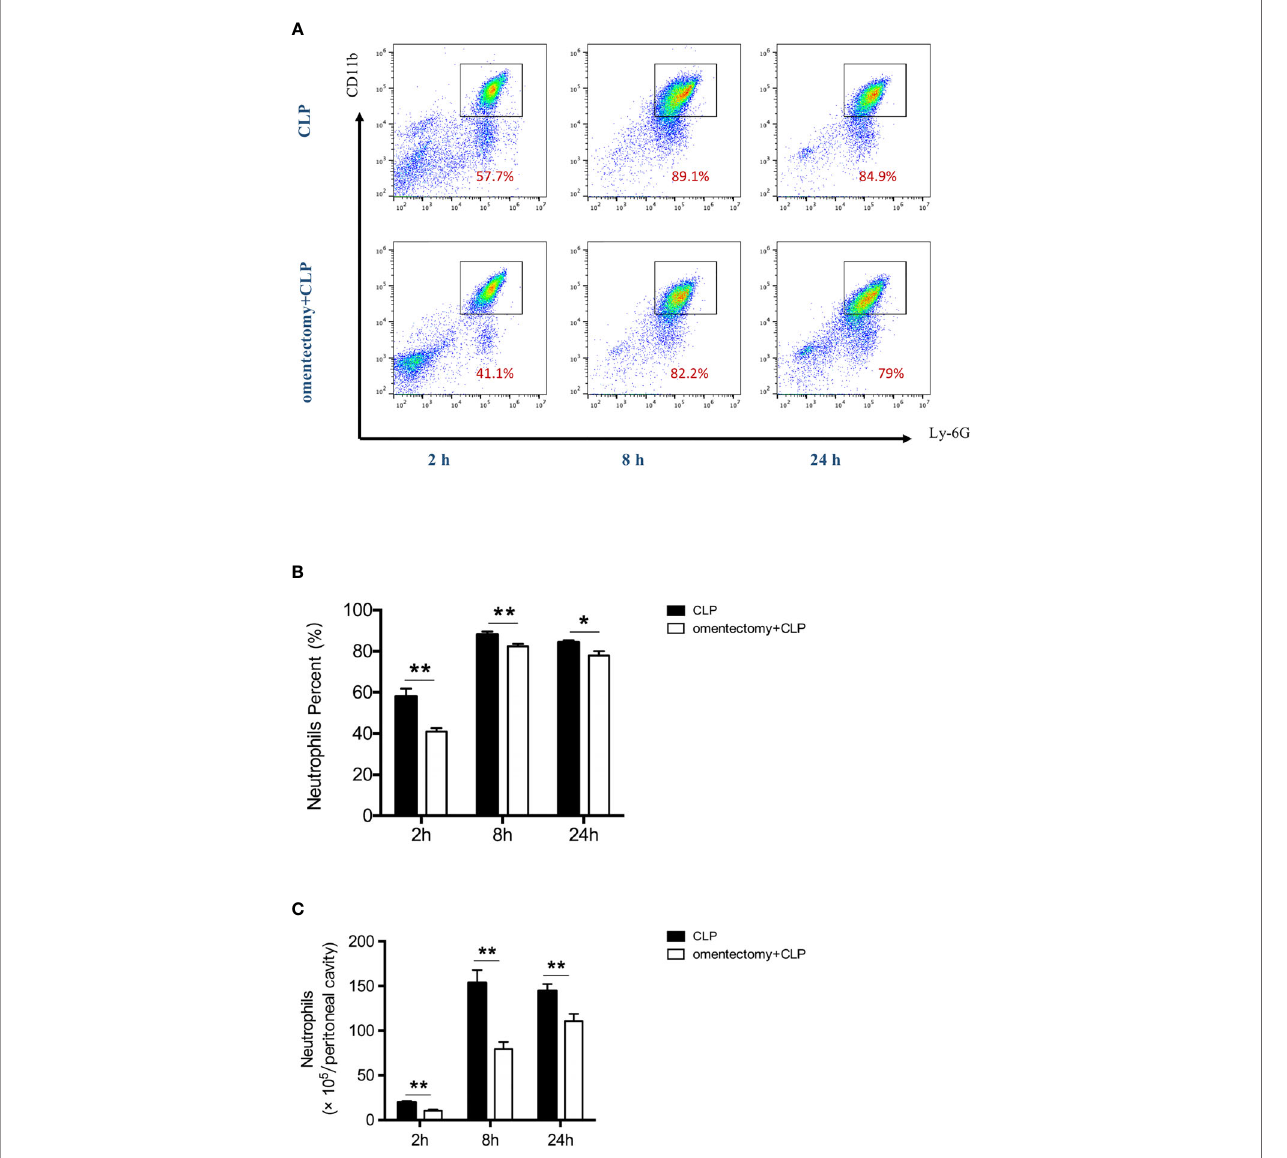
FIGURE 4 | The omentum regulates neutrophils recruitment during CLP-induced peritonitis. At indicated time intervals after CLP, peritoneal cells were collected from WT and omentectomized mice (n = 6 per group). Number indicates the percentage of CD11b and Ly6G double-positive cells, and the percentages (A, B) and numbers of neutrophils (C) were analyzed by fl ow cytometry. Results are expressed as means ± SEM. ** p < 0.01 and * p < 0.05 for omentectomized vs